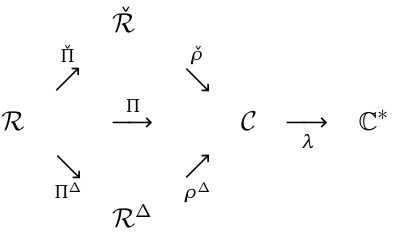
Figure 1: Summary of several useful covering maps between the Riemann surfaces considered in this